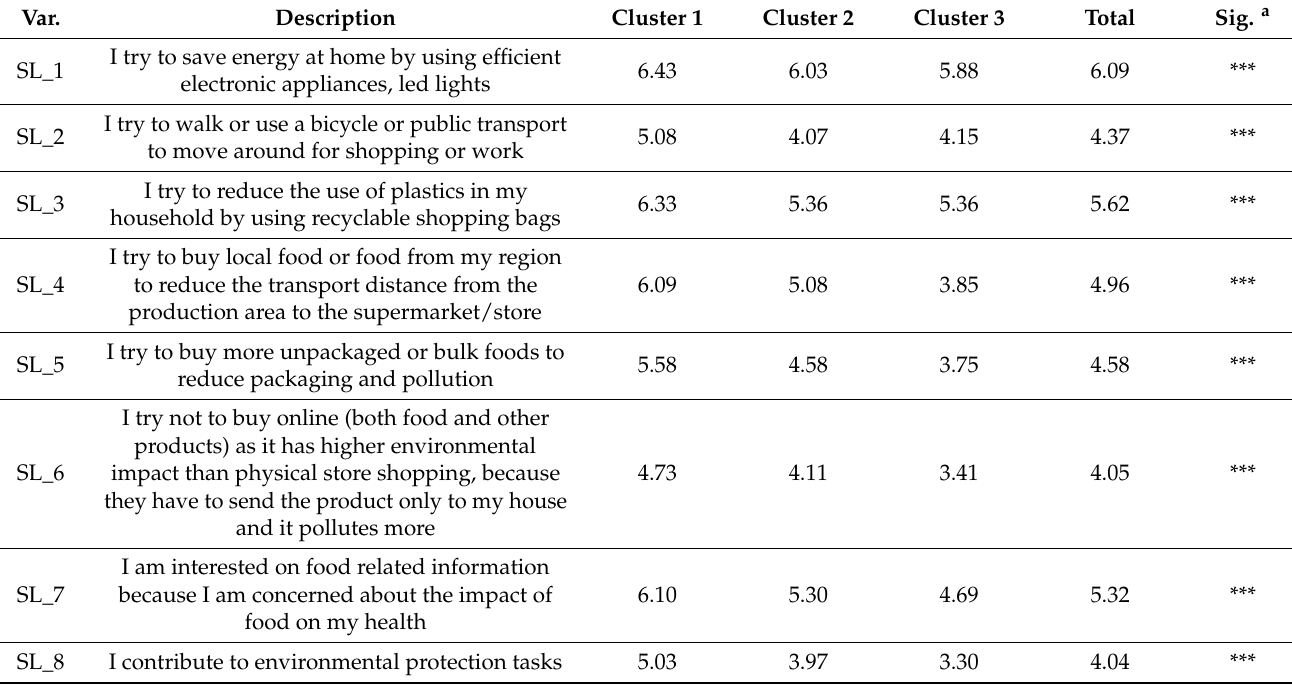
Table 5. Lifestyles and consumer attitudes towards the environment are scored against a number of statements that fully (7) or not at all (1) reflect their